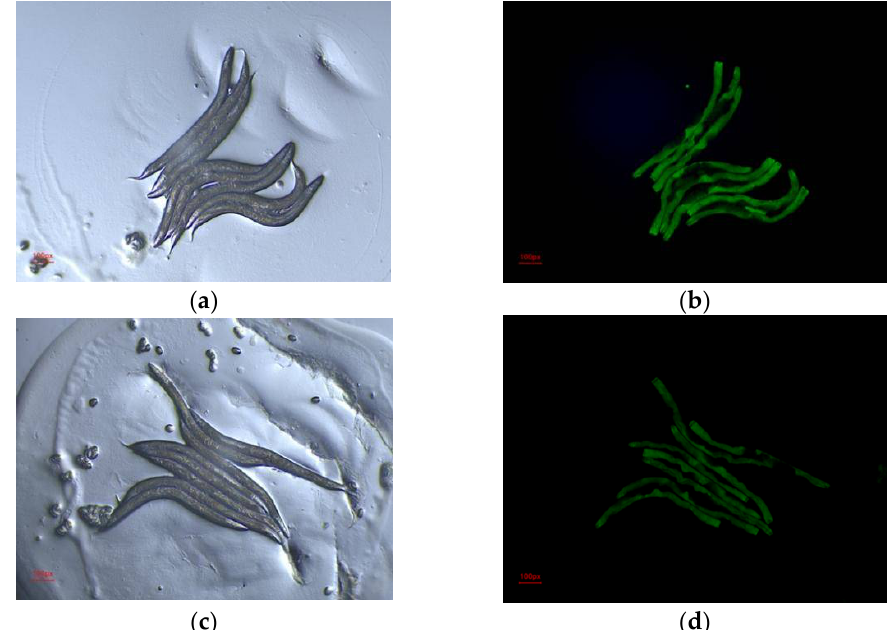
Figure 4. Representative images of dhs-3::gfp fluorescence in worms induced by DMSO and FEAK. ( a ) DMSO group (bright field, 100 px). ( b ) DMSO group (dark field,100 px). ( c ) FEAK group (bright field). ( d ) FEAK group (dark field).